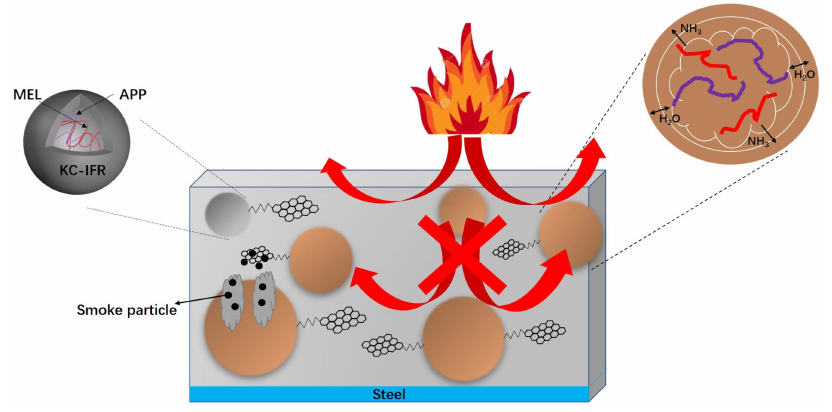
Figure 8. Schematic illustration of the flame-retardant mechanism of the flame-retardant